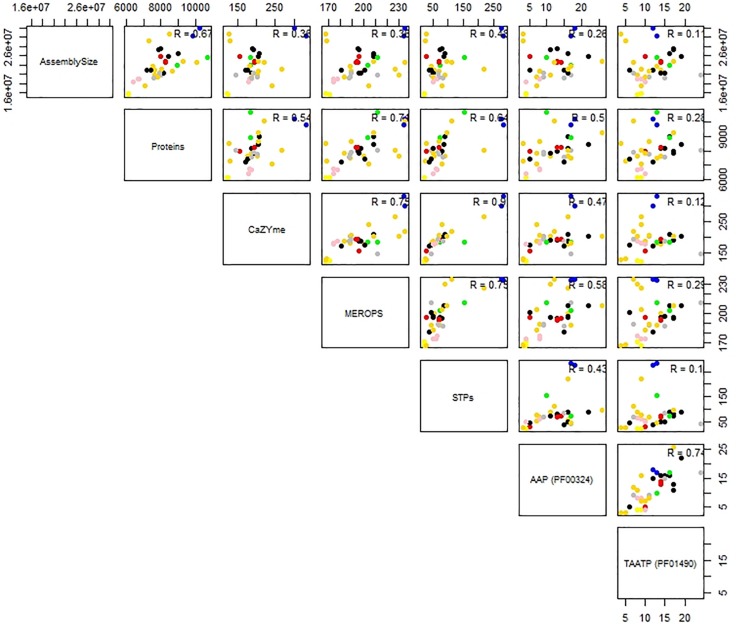
Correlation analysis of genome and proteome sizes, and predicted CAZYmes, peptidases, sugar, and amino acid transporters of thirty-five Tremellales. Coefficient of correlation R values indicates the strength of the association and niche specialization of the strains are color coded; black, blue, cyan, gold, green, gray, pink, red representing saprobic (arthropods frass), soil, saprobic (dead arthropods), saprobic (plants), mycoparasitic, saprobic (others), pathogenic, sea isolates, respectively.